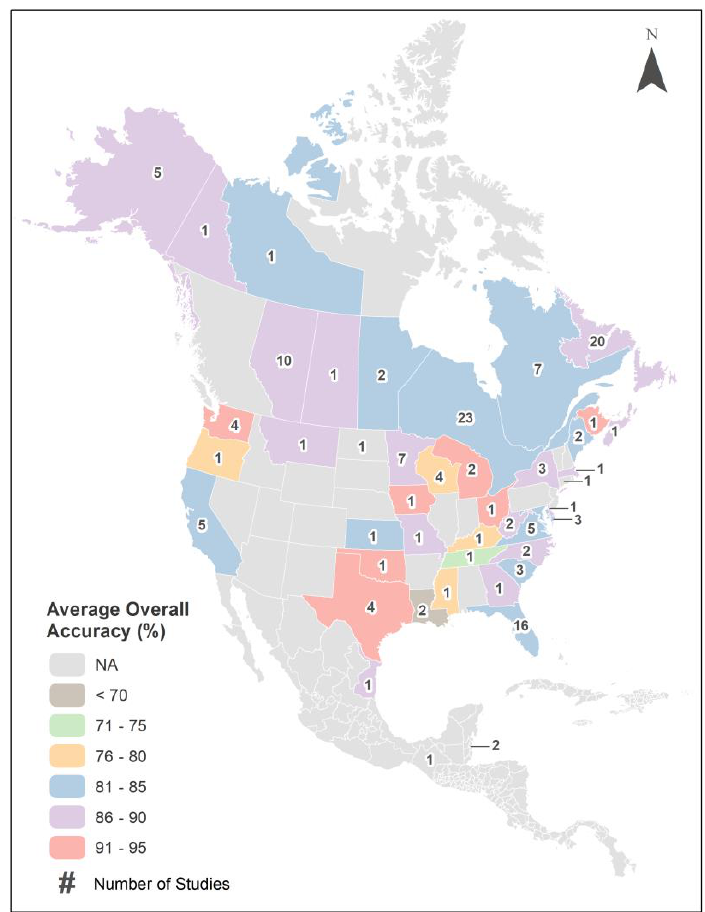
Figure 9. Average overall accuracy (colors) and the number of studies (numbers) in North American provinces, states, and regions.